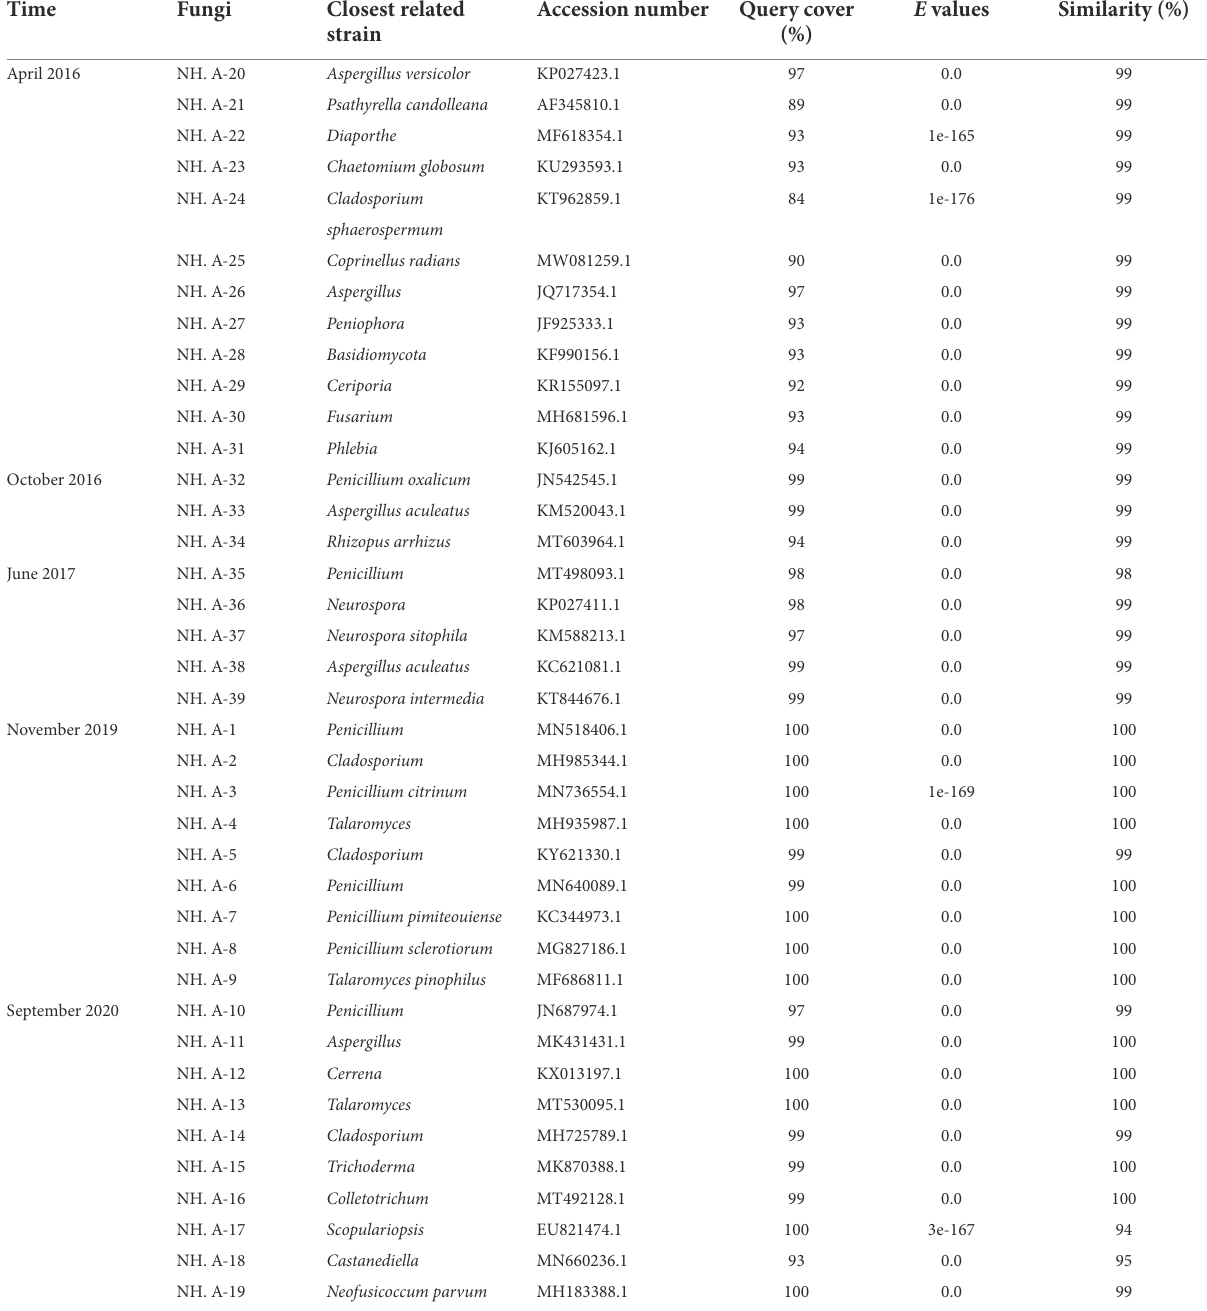
TABLE 2 Molecular identification of fungi isolated from the air in the protective environment of the Nanhai No. 1 Ancient Shipwreck. Time